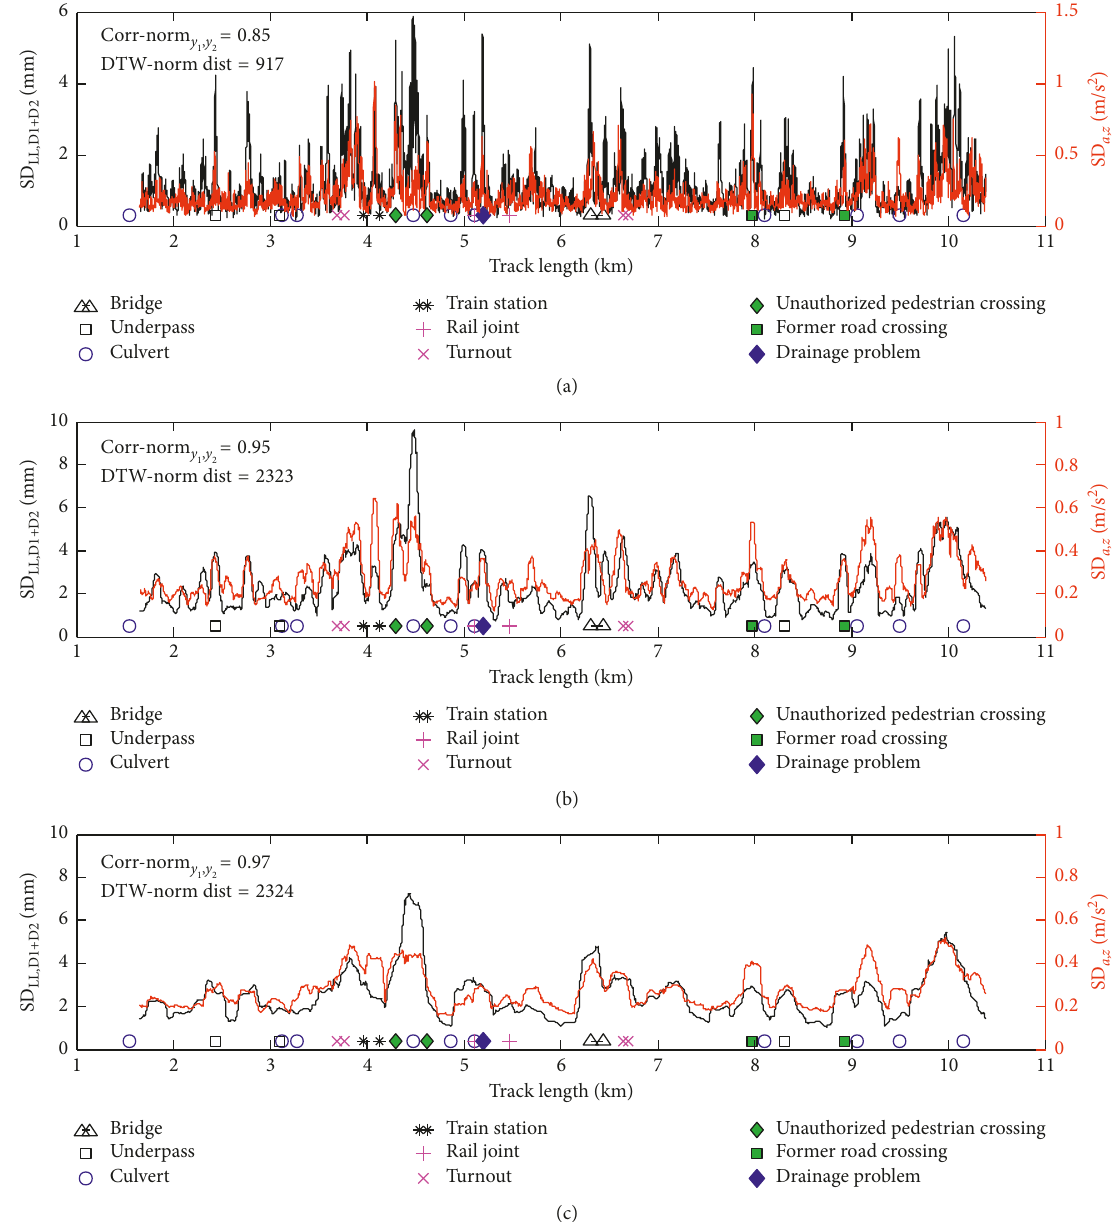
Figure 4: Comparison between the standard deviation of the longitudinal level (SD considering three sliding-window sizes: (a) 10m, (b) 75m, and (c)